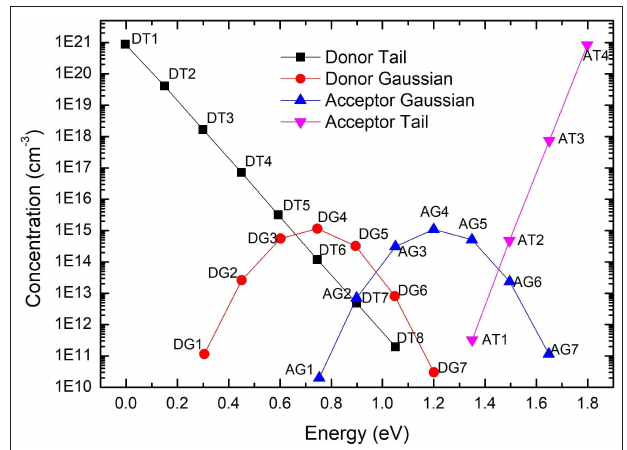
FIGURE 1 | Defect density or concentration (without weighting factor) of conduction and valence band tail states and Gaussian states within the a-Si:H material.